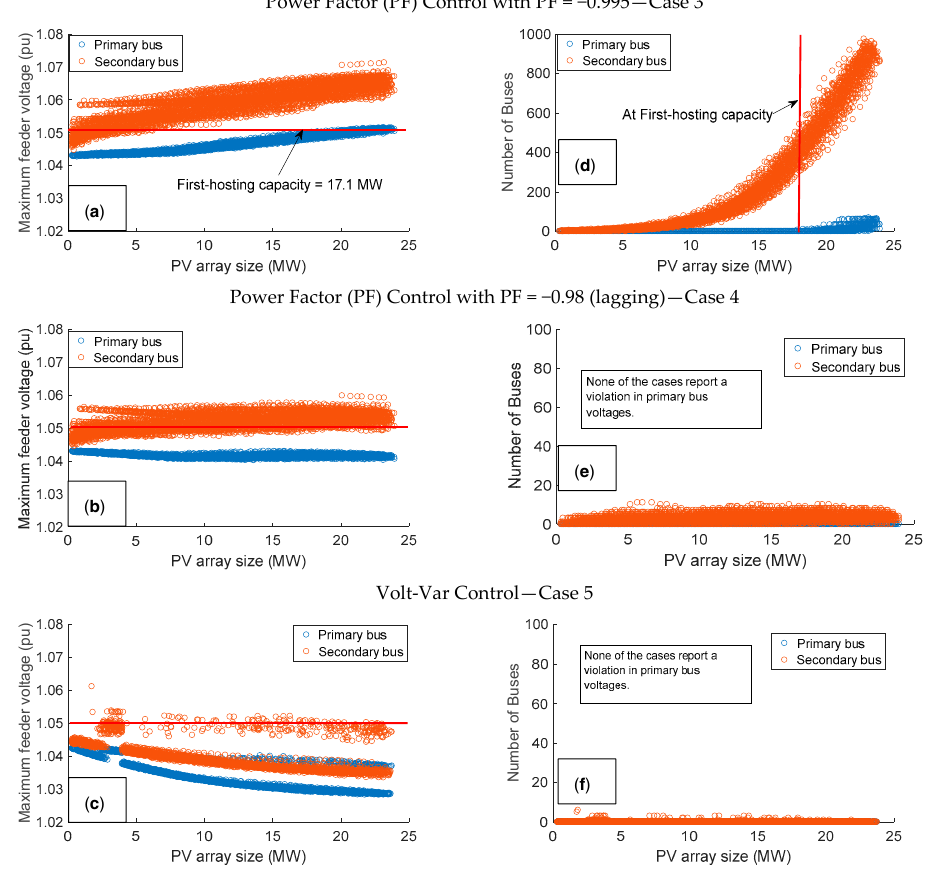
Figure 7. Smart inverter control: ( a – c ) Largest feeder voltages; ( d – f ) Number of bus voltage violations.